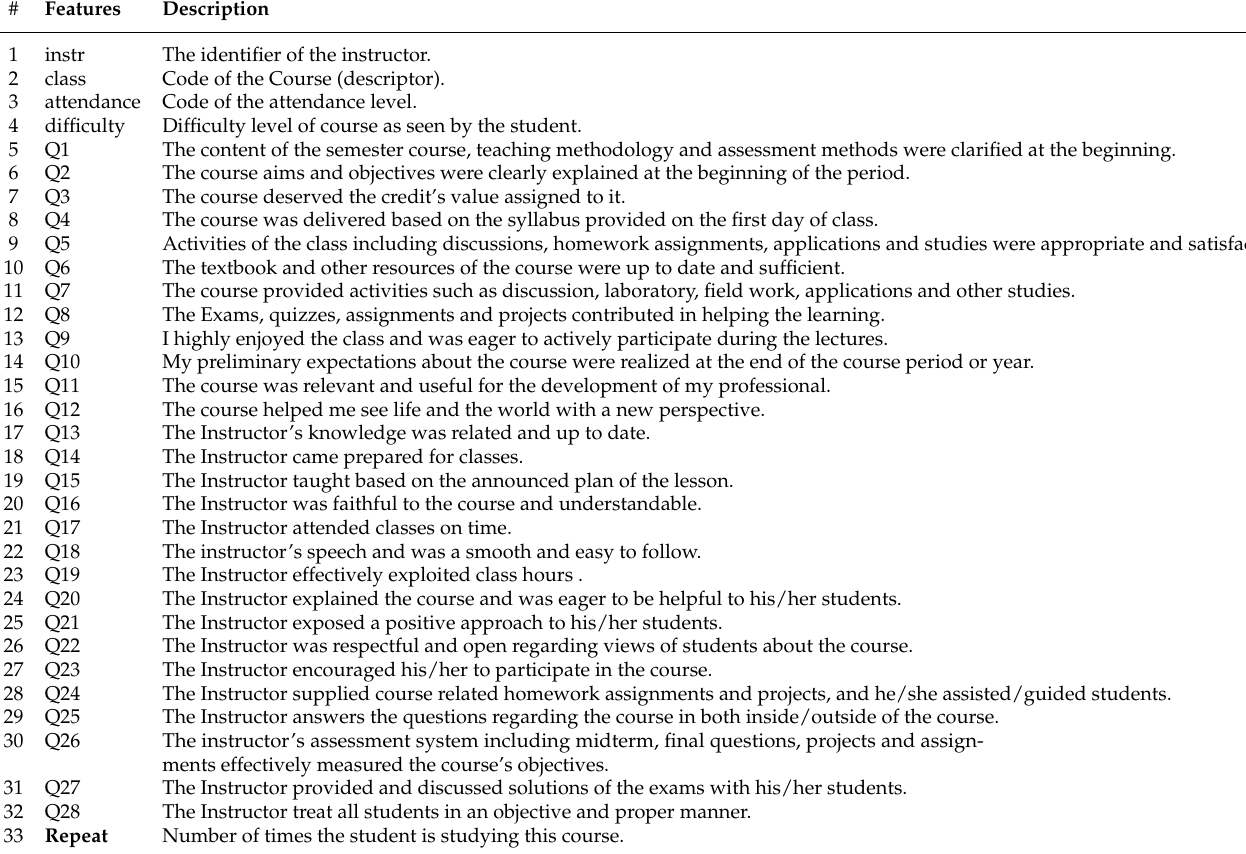
Table A2. Description of features for